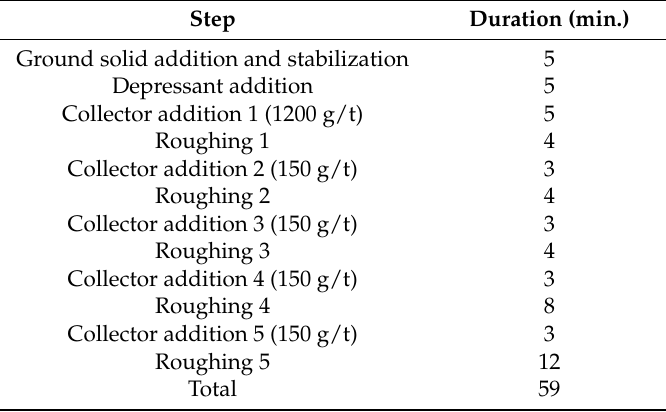
Table 2. Duration and collector addition for the flotation